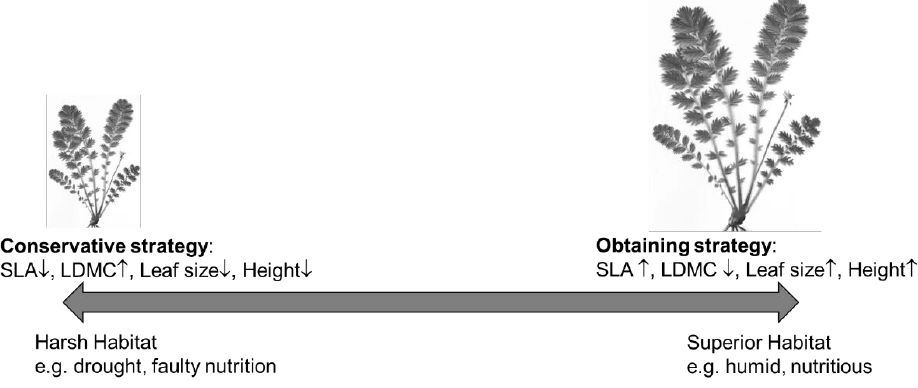
Figure 1. Plant resource strategy from ‘conservative’ to ‘acquisitive’ along the environmental gradient from harsh to superior conditions. SLA: specific leaf area; LDMC: leaf dry matter content.